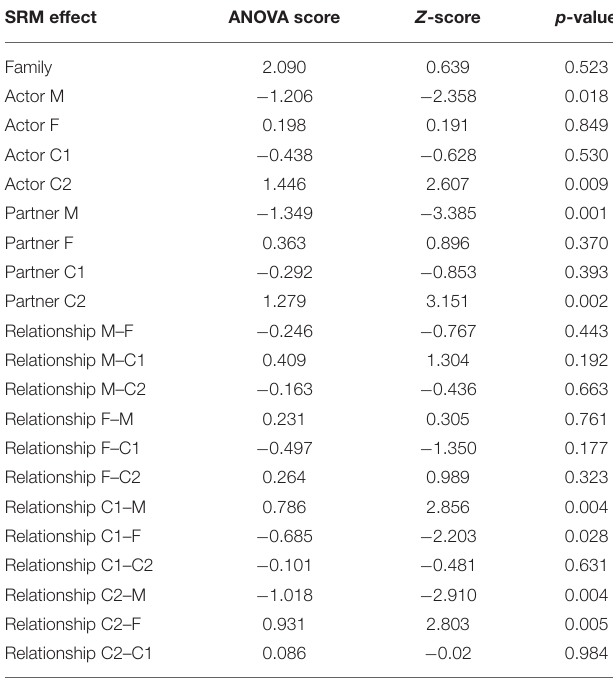
TABLE 6 | ANOVA scores, Z scores and p -values of the family of interest’s family assessment (M, mother; F, father; C1, oldest child; C2, youngest